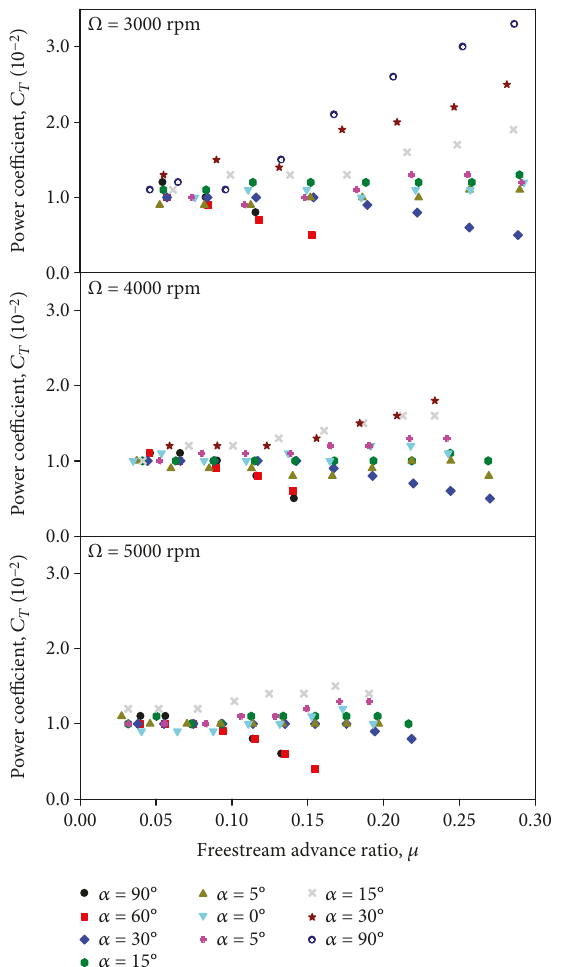
Figure 11: Roll moment coe ffi cient for T-motor 18x6.1 at various uncorrected angles of attack under di ff erent rotational